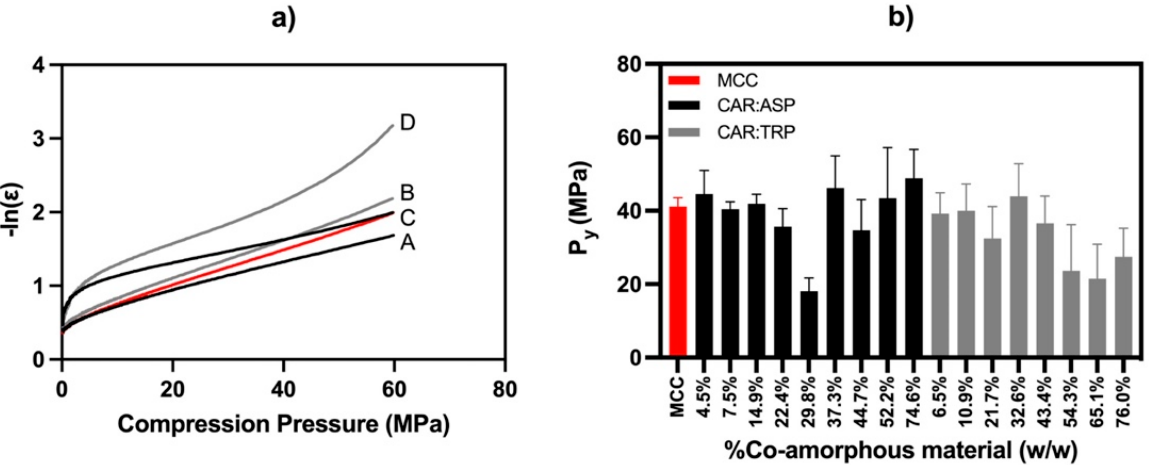
Figure 3. ( a ) Heckel model of 4.5% ( w / w ) CAR:ASP (A), 6.5% ( w / w ) CAR:TRP (B), 74.6% ( w / w ) CAR:ASP (C), 76.0% ( w / w ) CAR:TRP (D), and MCC (red line); ( b ) yield pressure derived from Heckel model as bar charts of MCC (red), CAR:ASP (black), and CAR:TRP (grey); n = 6, average ± st. dev.